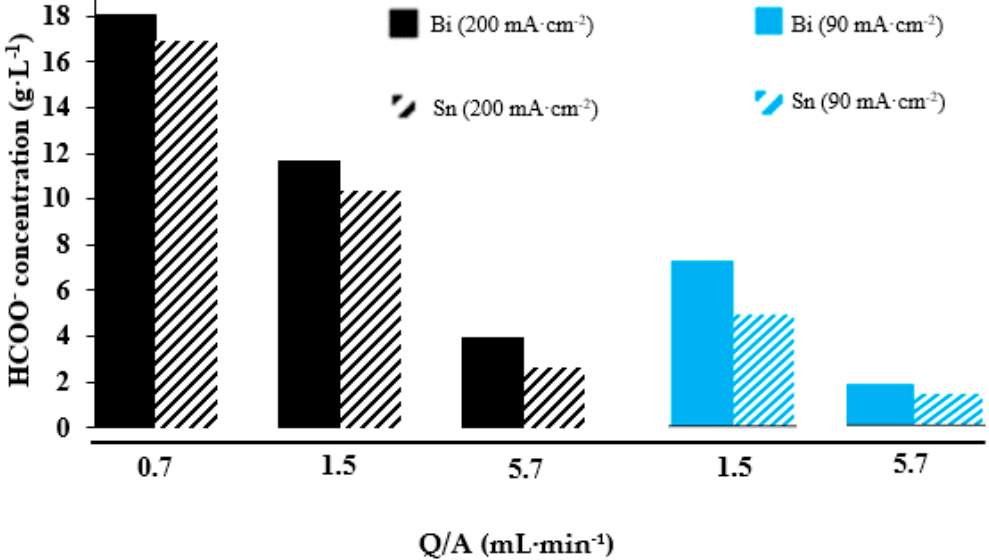
Figure 2. Influence of electrolyte flow on the HCOO − concentration (g·L − 1 ) in the electrolyte flow range of 0.7–5.7 mL·min − 1 applied at different current densities: 90 and 200 mA·cm − 2 and with different electrocatalyst material (Sn/C NPs and Bi/C NPs). Data taken from references [66] and [68].